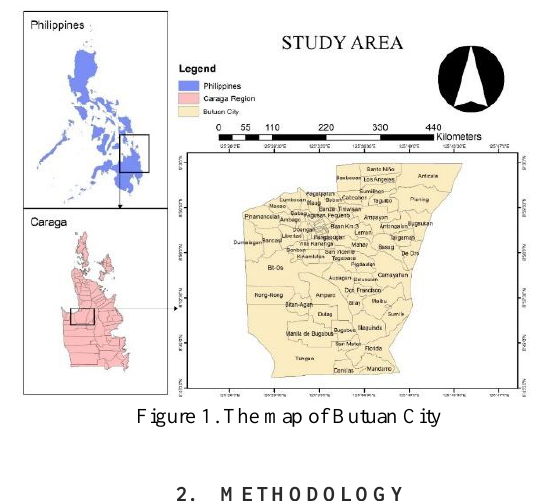
Figure 1. The map of Butuan